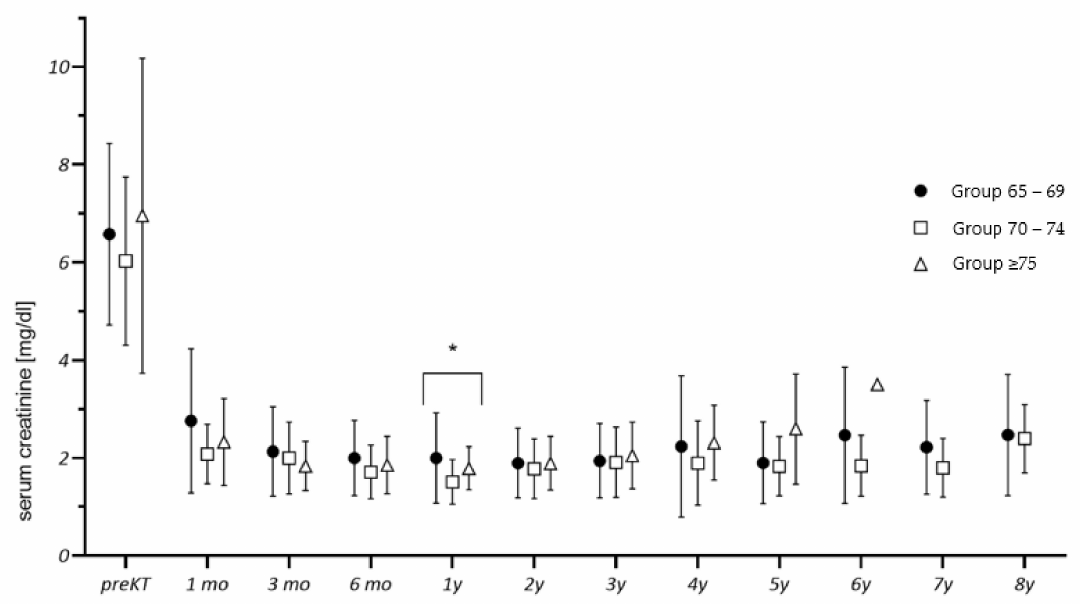
Figure 1. Graft function during follow-up. (* statistically significant difference between the groups). Figure 1 depicts the creatinine levels of the three age groups up to last follow- up. Figures 2 and 3 illustrate the death-censored graft and patient survival of the three age